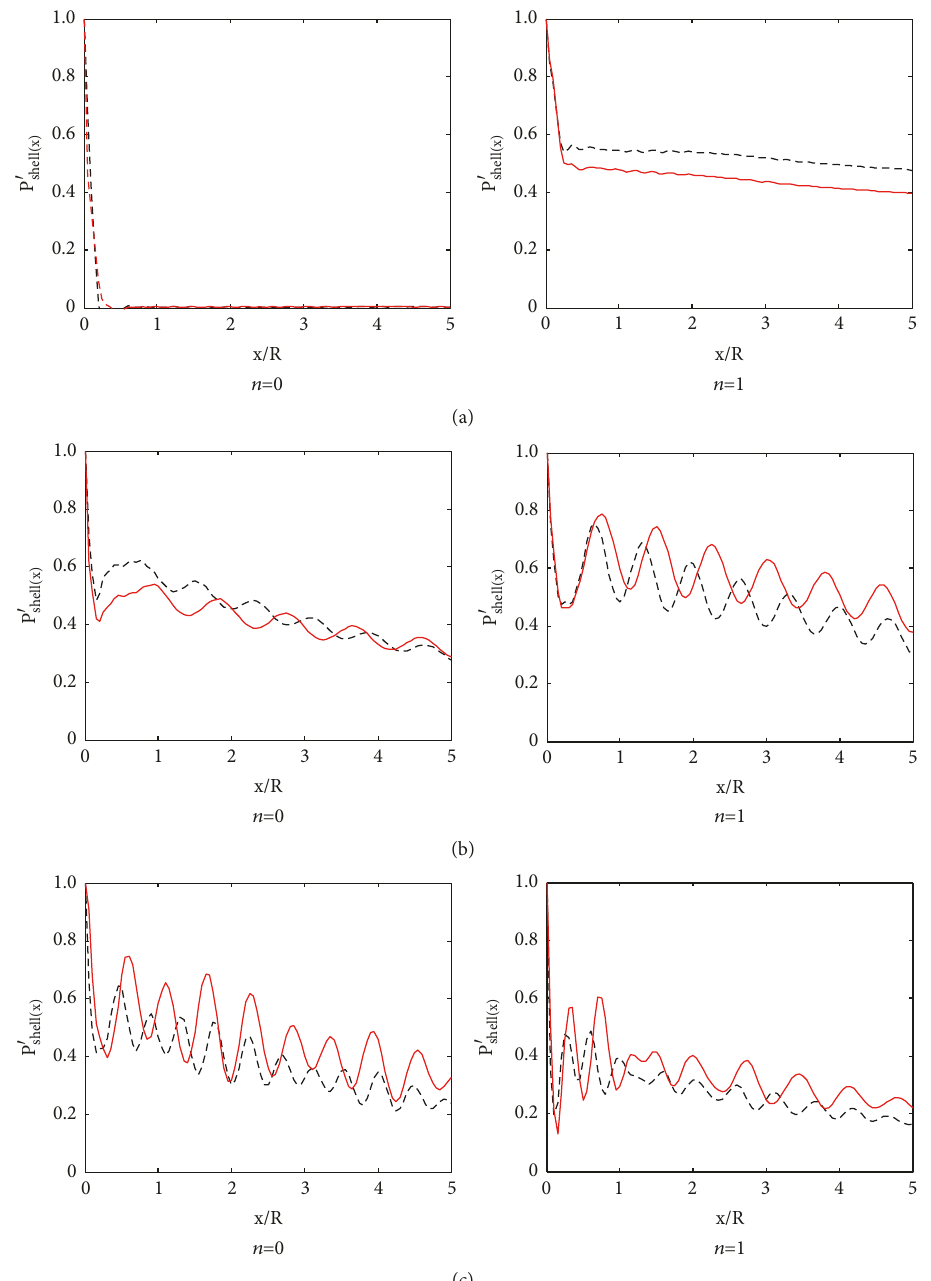
Figure 7: The comparison of power transmitted by the shell with different cross-ply: (a) Ω = 0.3 , (b) Ω = 1.2 , and (c) Ω = 3.0 ; black dashed line: [90 ∘ /0 ∘ /90 ∘ ]; red solid line: [0 ∘ /90 ∘ /0 ∘ ].